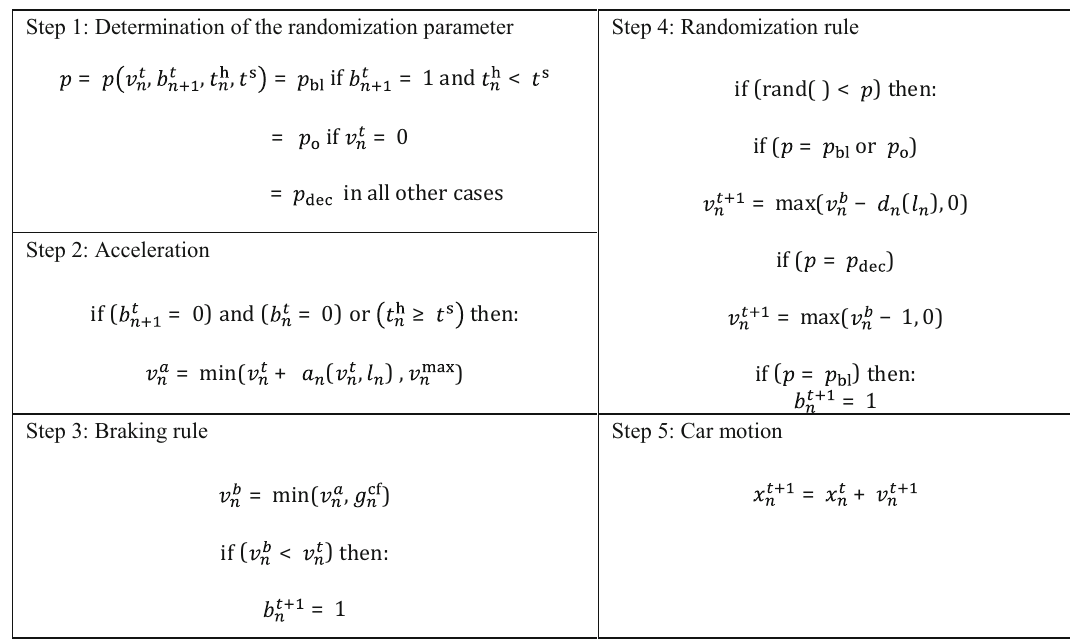
Fig. 3 Steps in longitudinal movement